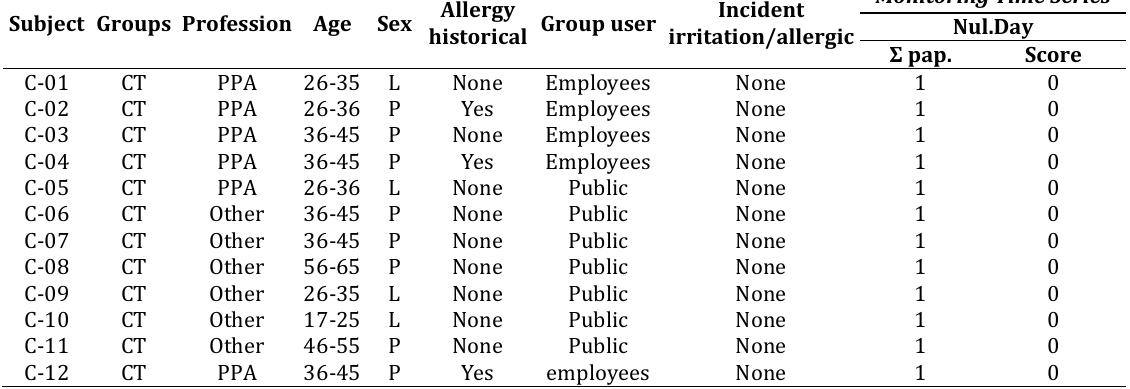
Subject Groups Profession Age